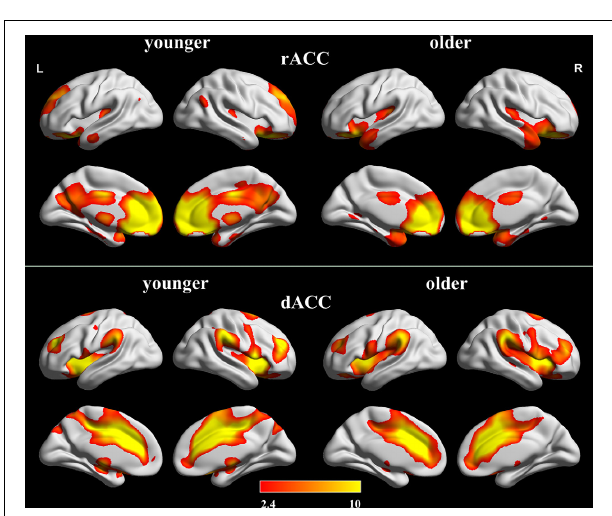
FIGURE 2 | Positive FC Maps of rACC and dACC in older and younger adults. The statistical threshold was P < 0 . 05 (FDR-corrected, k = 23 adjacent voxels). Color bar indicates the t -value. FC, functional connectivity; rACC, rostral ACC; dACC, dorsal ACC.